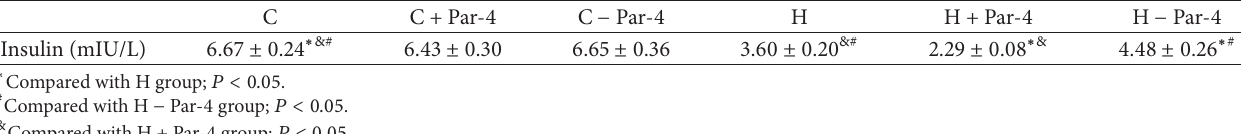
Table 1: The insulin secretion of each group.